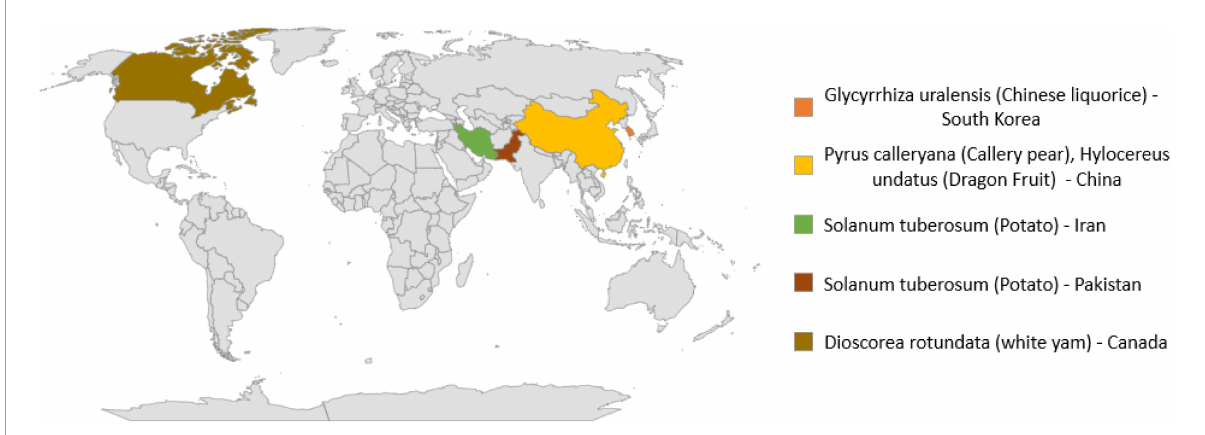
FIGURE2 Global distribution of Neocosmospora rubicola and host